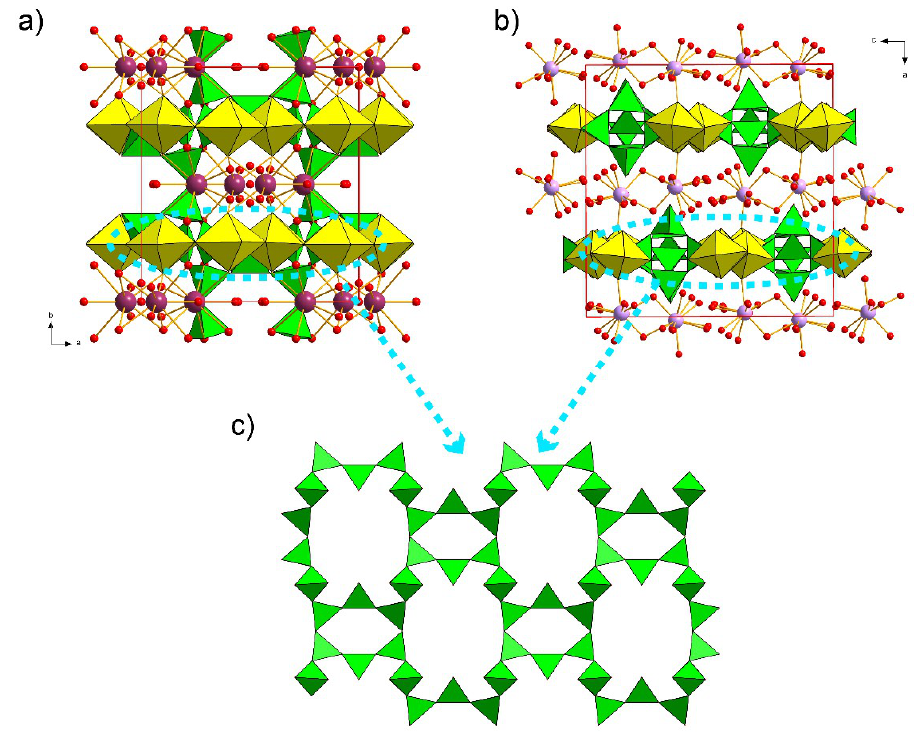
Figure 6. Crystal structures of weeksite-group minerals. ( a ) Weeksite viewed down [001]. UO 7 bipyramids are yellow, SiO 4 in green, K atom in violet, O atoms of the H 2 O in red. ( b ) Haiweeite viewed down [001]. Color scheme same as previous, except of Ca atoms (lavender). ( c ) Silicate sheet resulting from sharing of six-membered rings of Si-tetrahedra, which is present in the structure of both minerals.